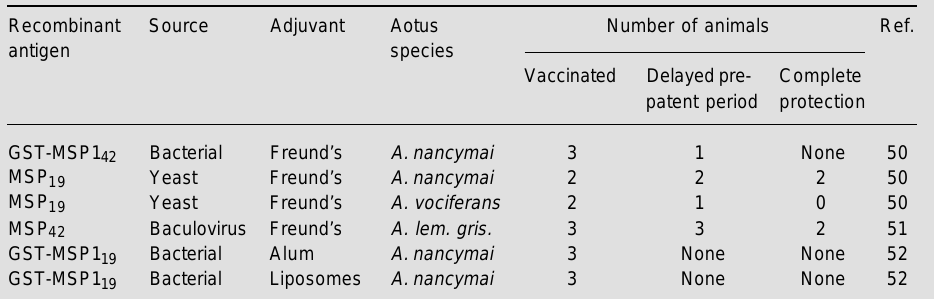
Table 1 - Summary of vaccination experiments in monkeys with recombinant proteins derived from the C- terminal region of Plasmodium falciparum MSP1.